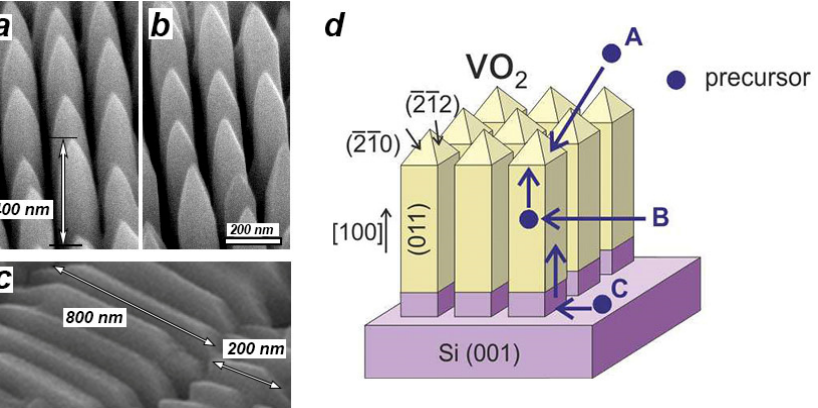
Figure 1. ( a , b ) Typical SEM images of the ordered array of free-standing vertical VO 2 NWs grown on a Si substrate in the form of a square nanopillar array. The lateral dimensions of each NW were 80 × 80 nm 2 ; they coincided with the lateral dimensions of the silicon nanopillars, their length being about 400 nm. ( c ) Typical SEM image of the ordered array of horizontal VO 2 NWs grown on a Si substrate in the form of an array of 80 nm width nanostrips with a 180-nm pitch. The approximate lengths of horizontal NWs are indicated with arrows. The height of these NWs was almost independent of their contact area with the substrate. ( d ) Schematic representation of an array of vertical VO 2 NWs. The purple arrows in ( d ) illustrate the mechanism of VO 2 NW growth, which includes the direct precursor deposition onto the NW apex (A), diffusion of precursor species to the NW apex from the lateral crystal faces of VO 2 NWs (B) and from the substrate surface through the lateral crystal faces (C).